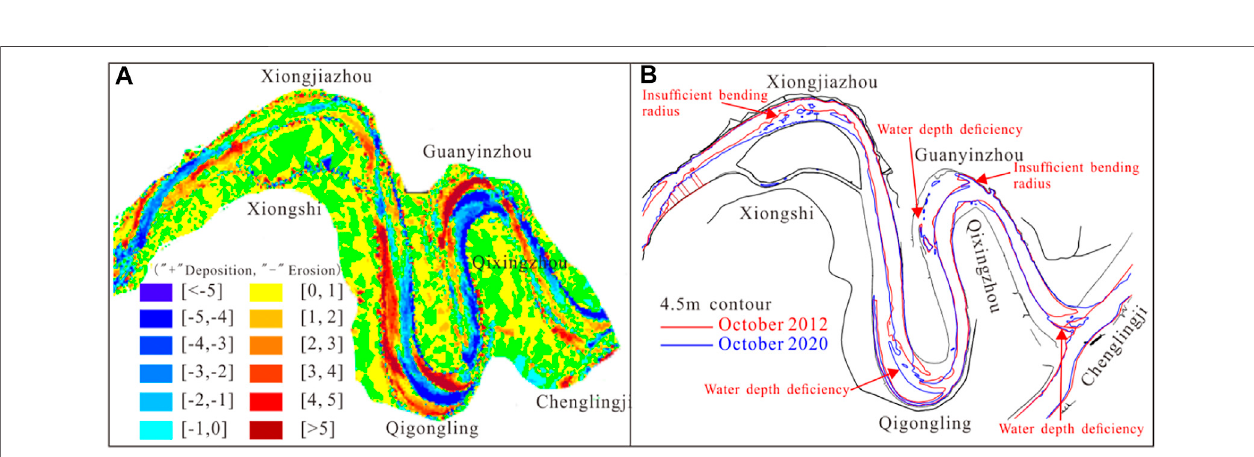
FIGURE 14 | Water depth condition of the bend channel of the Xiongjiazhou – Chenglingji reach; (A) River bed erosion and deposition distribution; (B) Length of 4.5 m isobath in the Xiongjiazhou – Chenglingji reach.